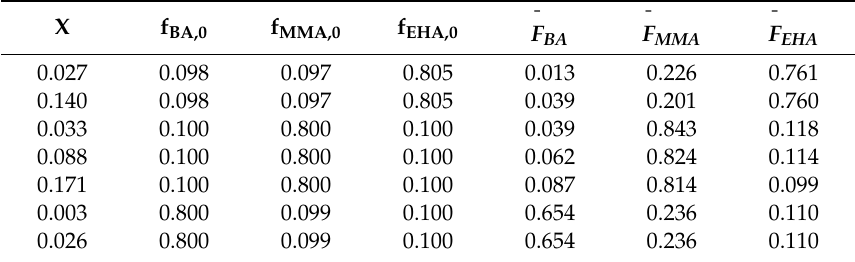
Table A2. Low conversion data for the BA / MMA / EHA terpolymerization (experimental data from Gabriel and Dub é [12]; see Section